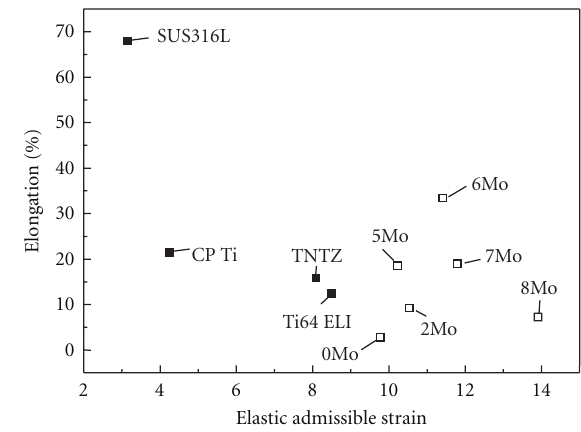
Figure 14: Young’s moduli of Ti-30Zr- x Mo ( x = 0, 2, 5, 6, 7, and 8mass%) alloys subjected to solution treatment and the alloys considered for comparison.